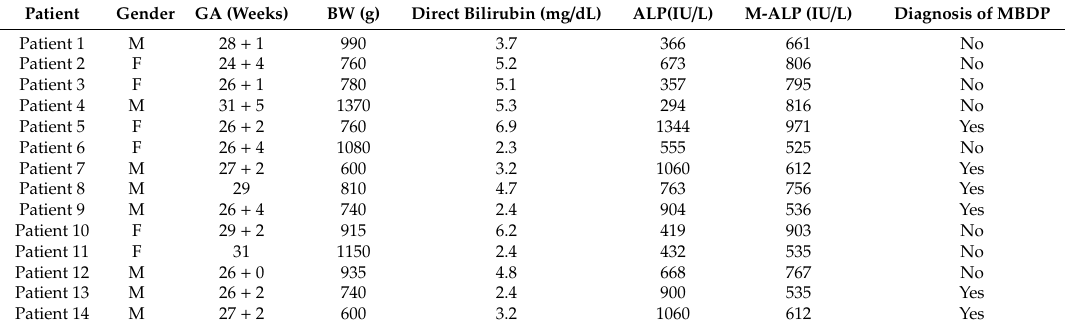
Table 2. Preterm features from the Cholestasis Group (ChG) with alkaline phosphatase (ALP) and modified ALP (M-ALP) values, and the condition of Metabolic Bone Disease of Prematurity (MBDP). Patient Gender GA (Weeks) BW (g)